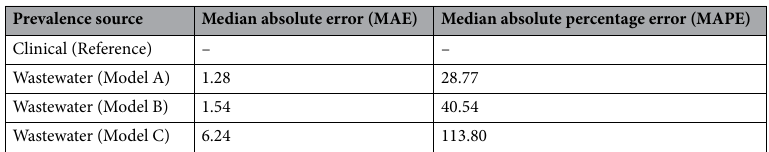
Table 2. Difference between wastewater-derived COVID-19 prevalence and clinical prevalence between May 26, 2020 and May 30, 2021 in Gainesville, FL. Median Absolute Error (MAE) and median absolute percentage error (MAPE) of the difference between the wastewater-derived COVID-19 prevalence estimate and the clinical prevalence (reference